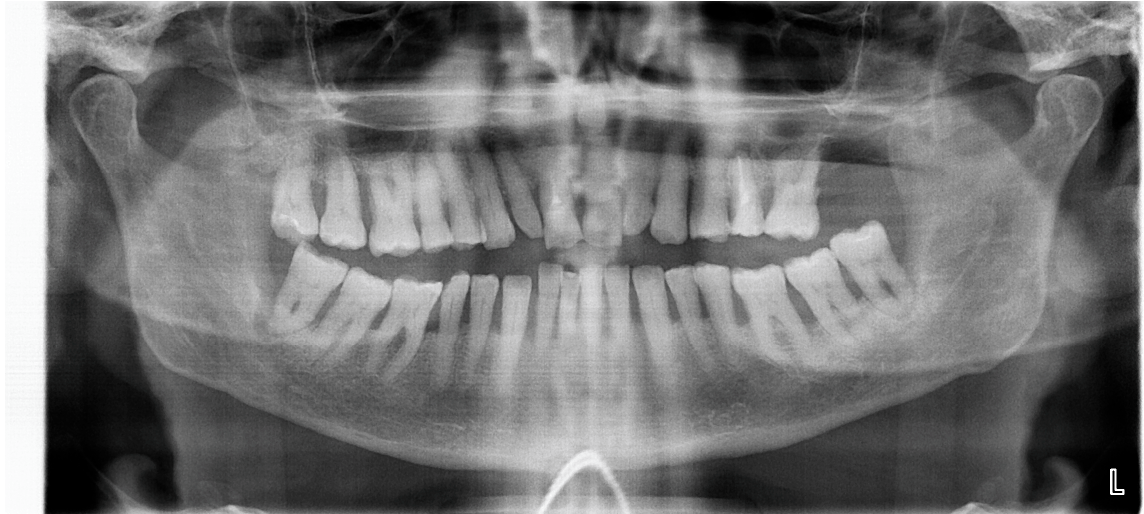
Figure 1. Periodontitis (radiographic appearance). A 37-year-old woman with generalized severe periodontitis (degree II–III). There is extensive alveolar bone loss (usually 50–75% of the root length) affecting the entire tooth row, with an irregular pattern of bone loss. Some teeth have lost almost all of their alveolar bone support as a result of the progression of periodontitis, such as the upper right molars and four lower incisors, all of which are mobile and held in the mouth only by soft tissue attachment (having lost over 85% of their bone support). Index R. Attsrom—37/02/00/05/20/0.